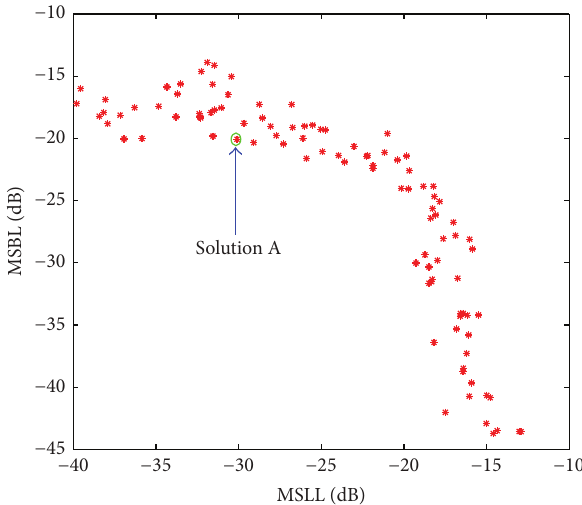
Figure 5: The schematic diagram of the antennas positioned on the conical surface with the 𝜃 -feed points in the feed points in the ̂𝜑 -direction.